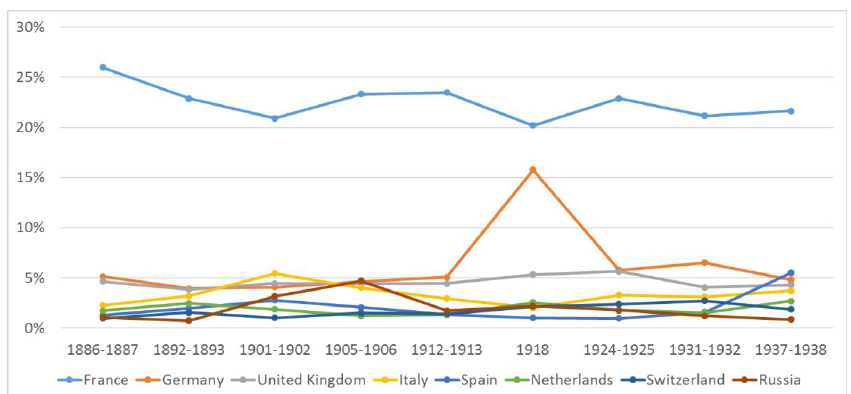
Figure 2: Most frequent countries of origin in Le Peuple throughout the years (excluding Belgium,